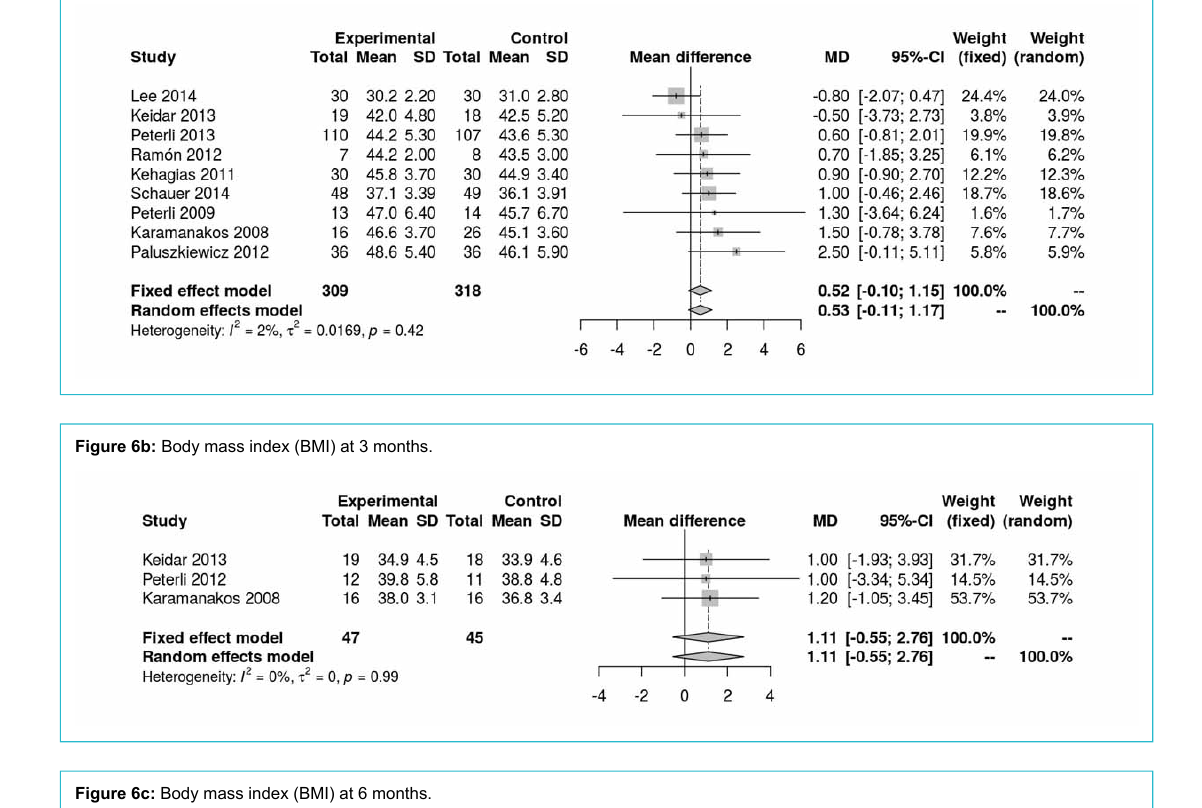
Figure 6c: Body mass index (BMI) at 6 months.